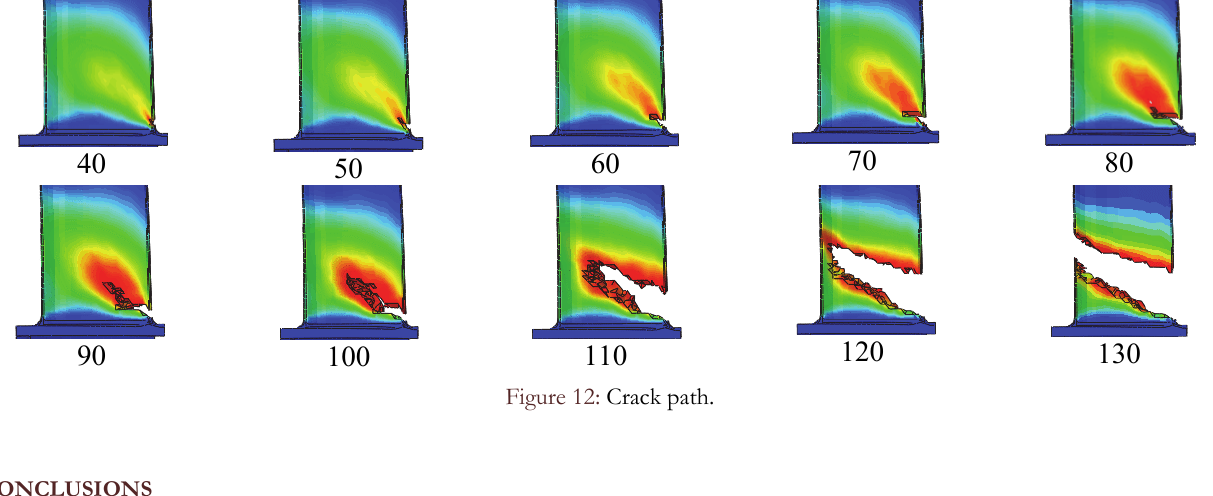
Figure 12: Crack